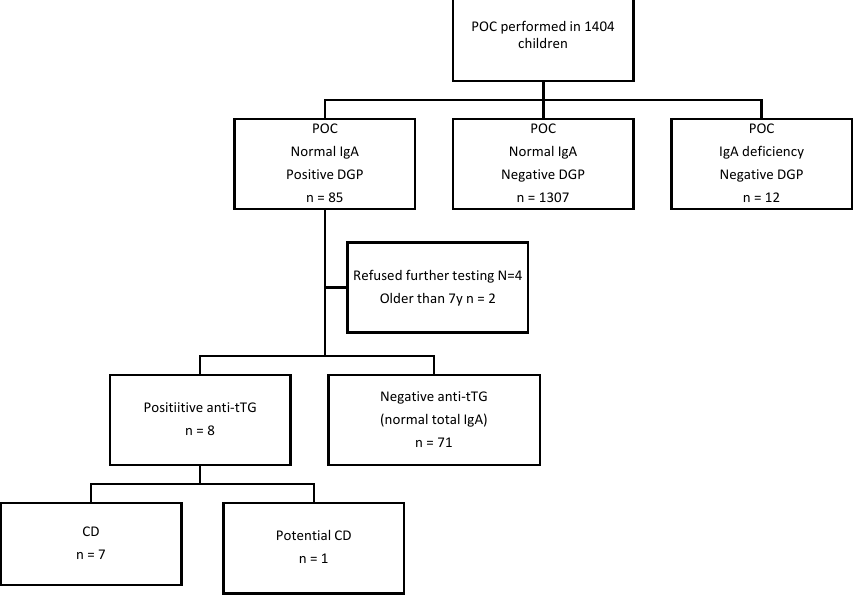
Figure 1. Flow chart of the screening.